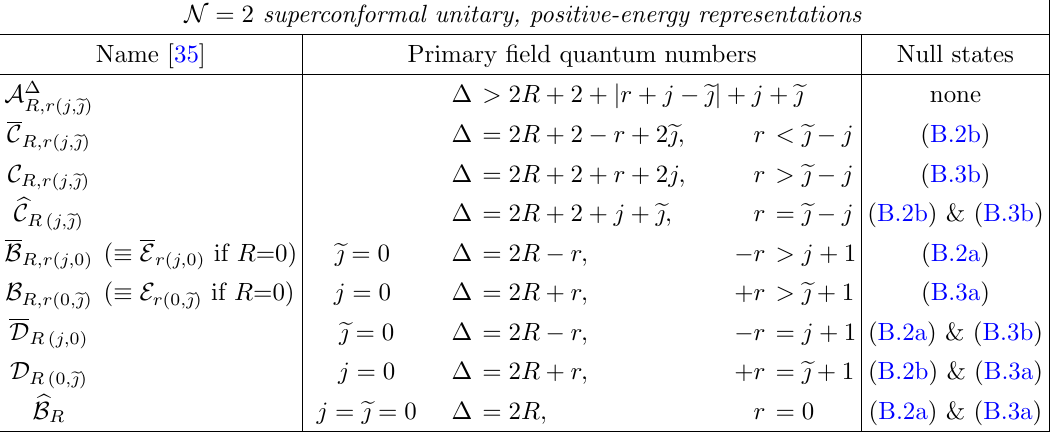
Table 5 . The names of the representations are given along with the constraints satis(cid:12)ed by the Lorentz spins ( j; e | ), R-spin R , u(1) R charge r , and dimension (cid:1) of their primaries. The independent null states of each type of representation are also